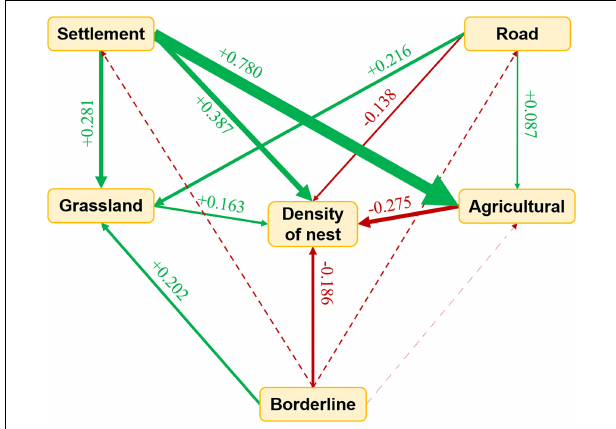
FIGURE 3 | Results of the structural equation model analyzing the relationship of distance from borderline, distance from grassland, distance from agricultural land with distance from road, density of wild boar’s nest, distance from settlements, p < 0.05. For all paths of the final path model, arrow width is proportional to the relative strength of standardized path coefficients, ( P = 0.181, χ 2 = 3.417, d.f. = 2). Red and green arrows indicate opposite and consistent trends, respectively. The consistent trends between borderline, grassland, agricultural land, road, settlements with the density of nest indicated that the closer the distance from variable was, the lower the density of nest was. The opposite trends means that the closer the distance from variable was, the higher the density of nest was. The consistent trends between variables means that the closer the nest to variable 1, the closer the nest to variable 2. The opposite trends means that the closer the nest to variable 1, the further the nest to variable 2. Interrupted lines indicate the relationship none significant.